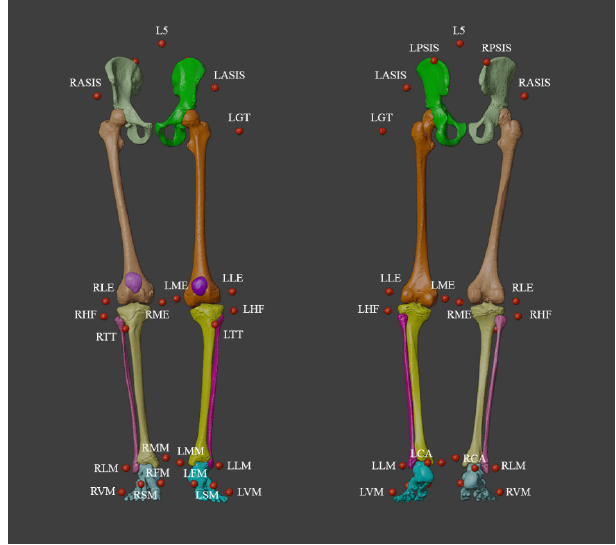
Figure 6. On the right the marker from the associated model, on the left the marker from CT not yet associated.